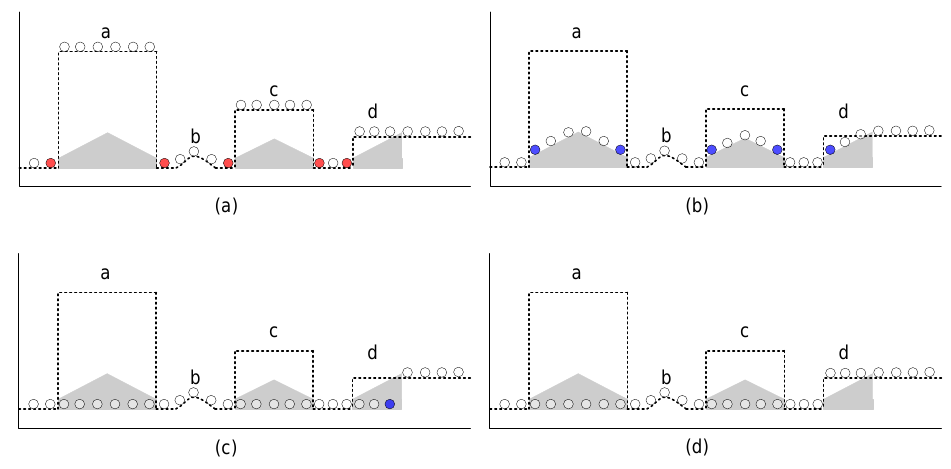
Figure 4. Example of the morphological filter by combining geodesic transformations: ( a ) original point